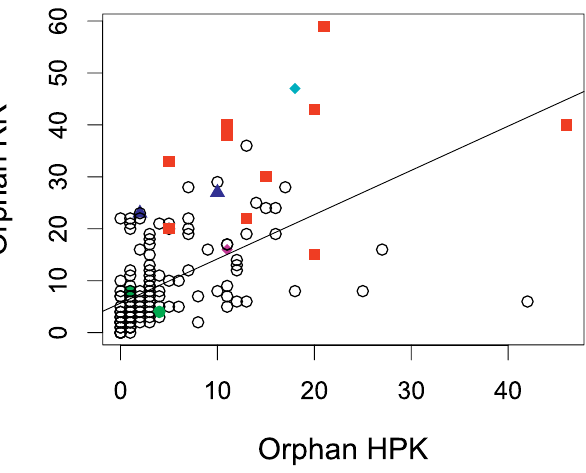
Figure 6. Coevolution of Orphan HPKs and RRs The number of ‘‘ orphan ’’ HPKs is plotted versus the number of ‘‘ orphan ’’ RRs. A moderate but highly significant linear correlation is observed